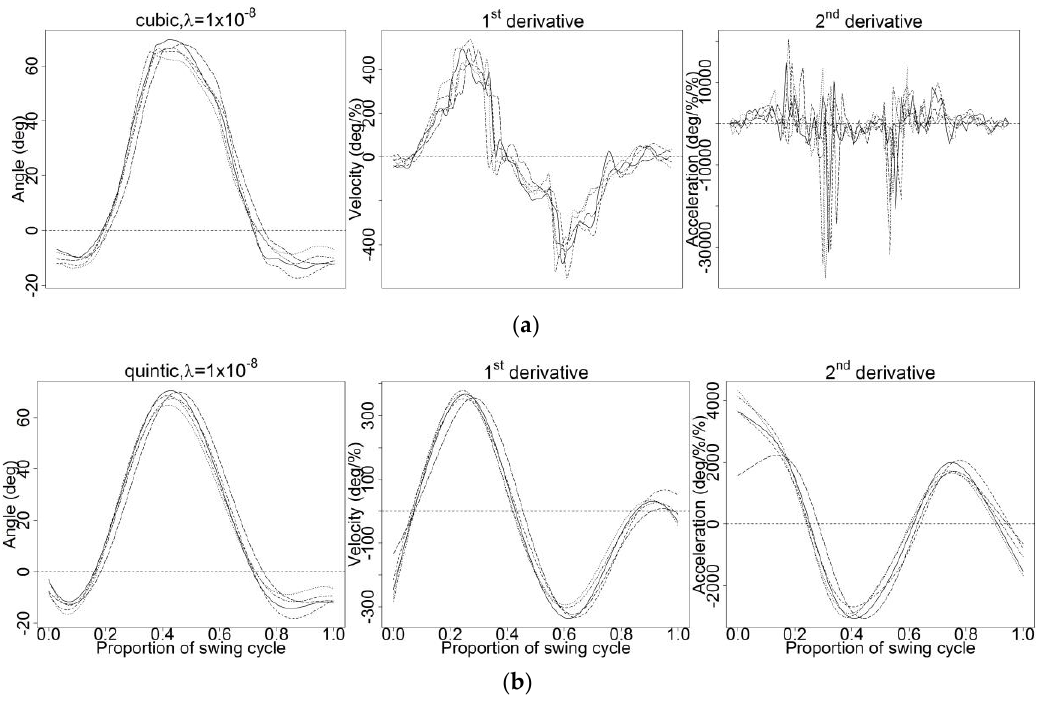
Figure A2. Smoothing with λ = 1 × 10 − 8 obtained from using generalized cross-validation (GCV) method using ( a ) cubic spline basis and ( b ) quintic spline basis.